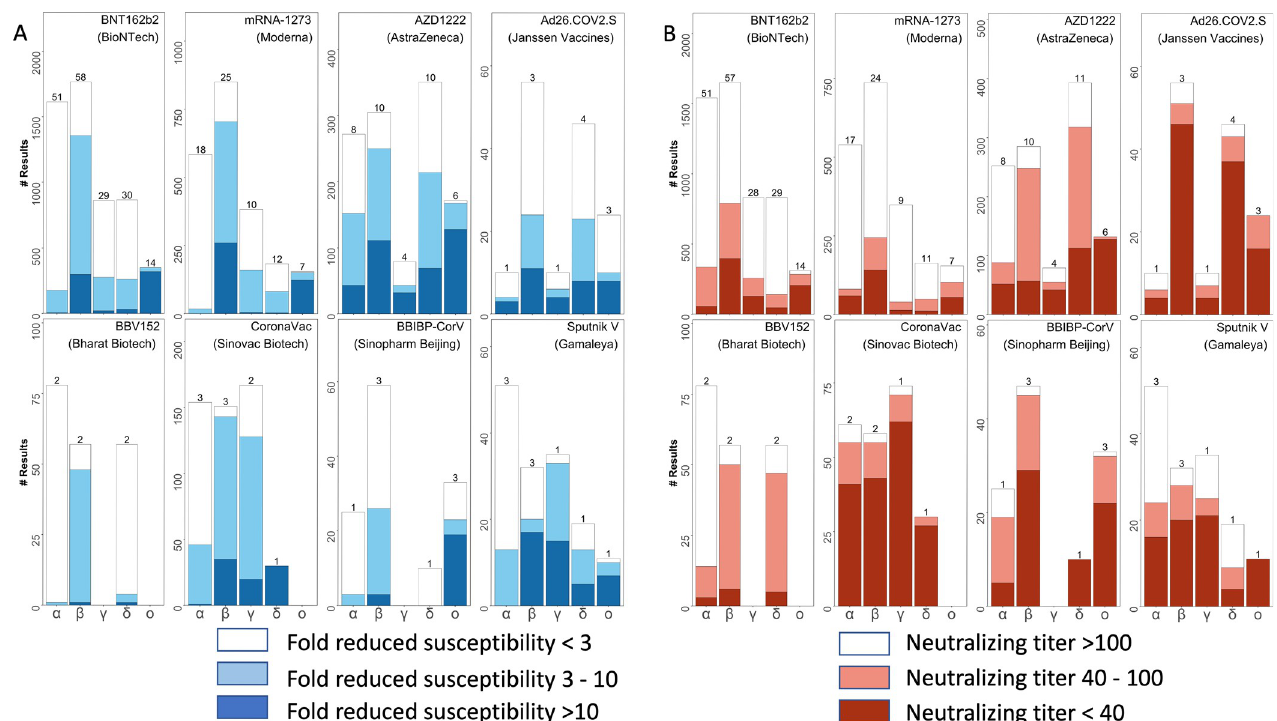
Fig 2. Distribution of fold-reduction in susceptibilities (A) and of absolute neutralizing titers (B) of vaccinee plasma (VP) associated with eight vaccines to the five variants of concern (VOC): Alpha, Beta, Gamma, Delta, and Omicron. The X axes indicate the Greek letter associated with each VOC. The Y axes indicate the number of neutralizing assays. The numbers above the stacked bars indicate the number of studies reporting the experimental results. The figure includes VP obtained solely from previously uninfected persons one month after receiving completing initial vaccination.